Question: Give a one-sentence summary of this figure.
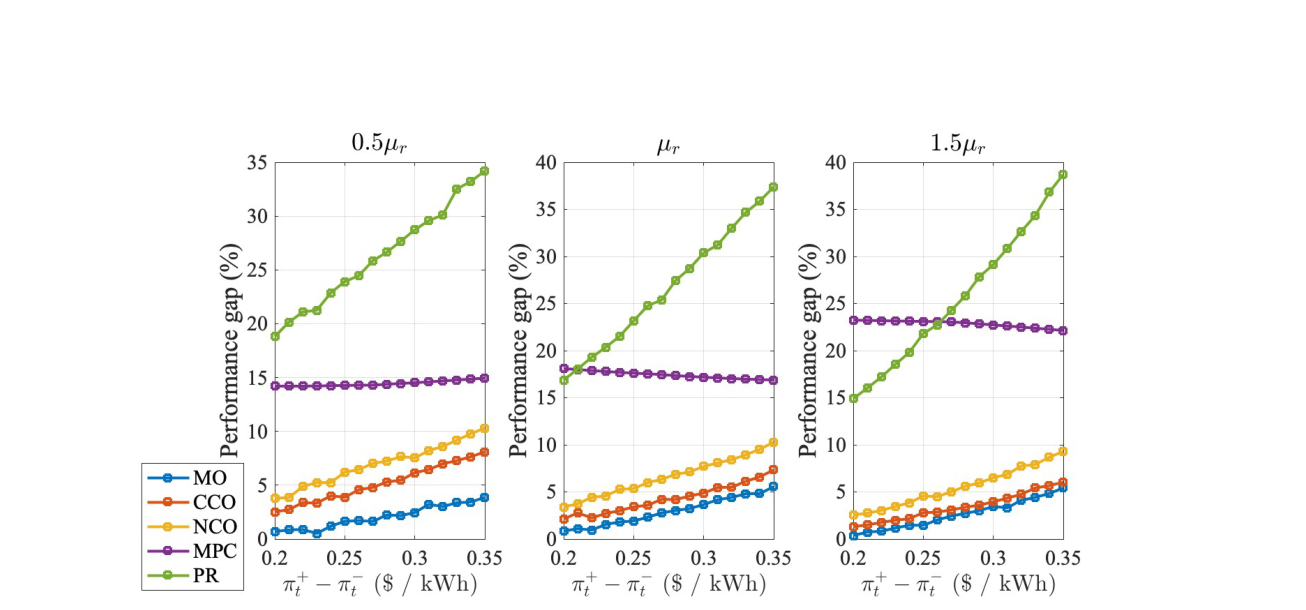
Answer: Relative performance gap of the MO(blue), CCO(red), NCO(yellow), MPC(purple), PR(green) to the oracle policy for different π+ t −π− t is plotted. The estimated mean of renewable is scaled by 0.5, 1, 1.5 for the figures from left to right.